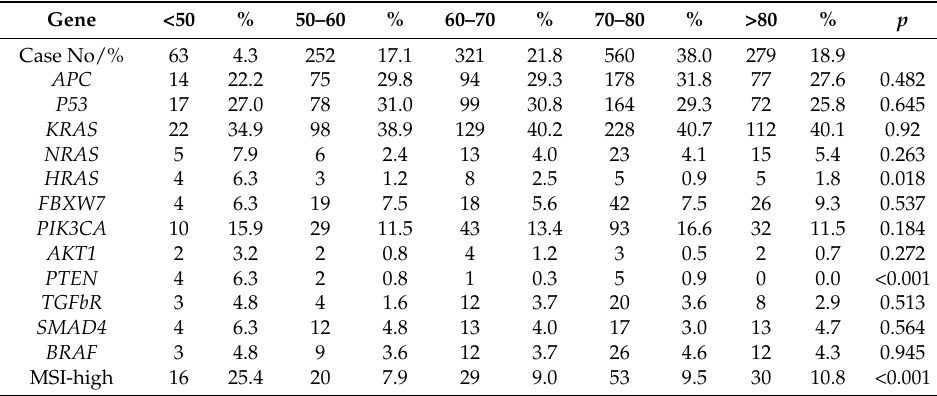
Table 2. Number and frequency of molecular alterations in different age groups of CRC patients.